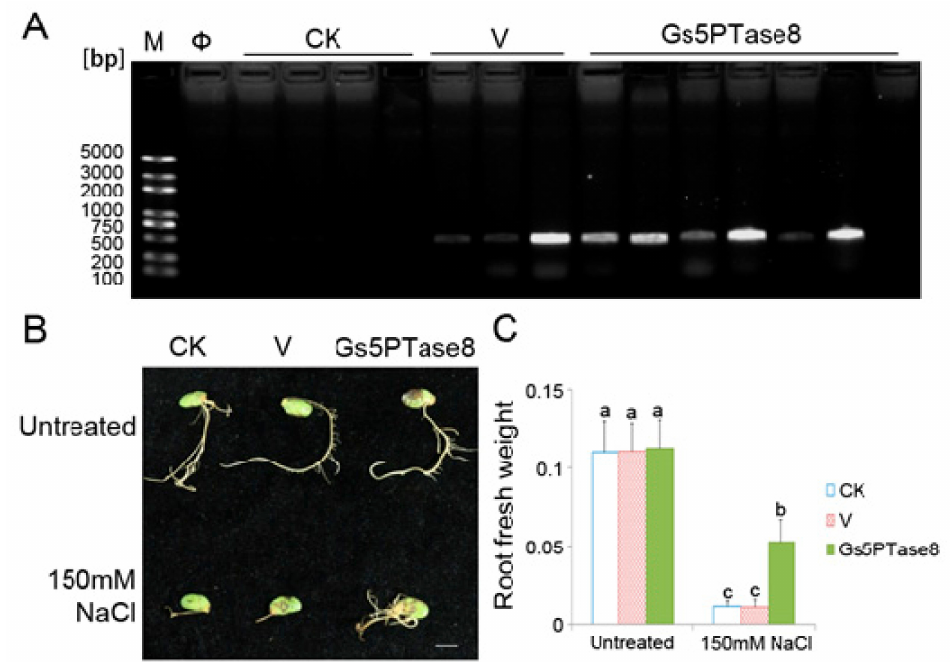
Figure 3. Growth characteristics of soybean hairy roots under salt treatment. The cotyledons of the geminated soybean seeds were infected with the wild type of A. rhizogenes stain K599 (CK), K599 containing the empty vector pTEV8 (V) or K599 containing the recombinant construct V7-Gs5PTase8 (Gs5PTase8), respectively. The cotyledons with the hairy roots of around 1 cm were selected for salt treatment. The selected hairy roots were grown with 1 / 2 Hoagland solution containing 0 mM NaCl and 150 mM NaCl for 10 days. ( A ) PCR verification of the positive transformants. The primers of the NPTII gene (kanamycin selection marker) from the binary vector pTEV8 were used for the genotyping PCR. The successful transformants of the empty vector and the recombinant construct would have a PCR product of 400 bps. M represents for DNA marker; Φ , Milli-Q water control of PCR reaction; bp, base pairs. ( B ) Phenotype of hairy roots. Scale bar indicates 1 cm. ( C ) Fresh weight of hairy roots. Sample means with standard errors (SE) were calculated with three replicates each containing 5–6 soybean cotyledons. The significant tests were performed using ANOVA (Duncan’s test, p < 0.05). The significant di ff erences were indicated by di ff erent letters above the